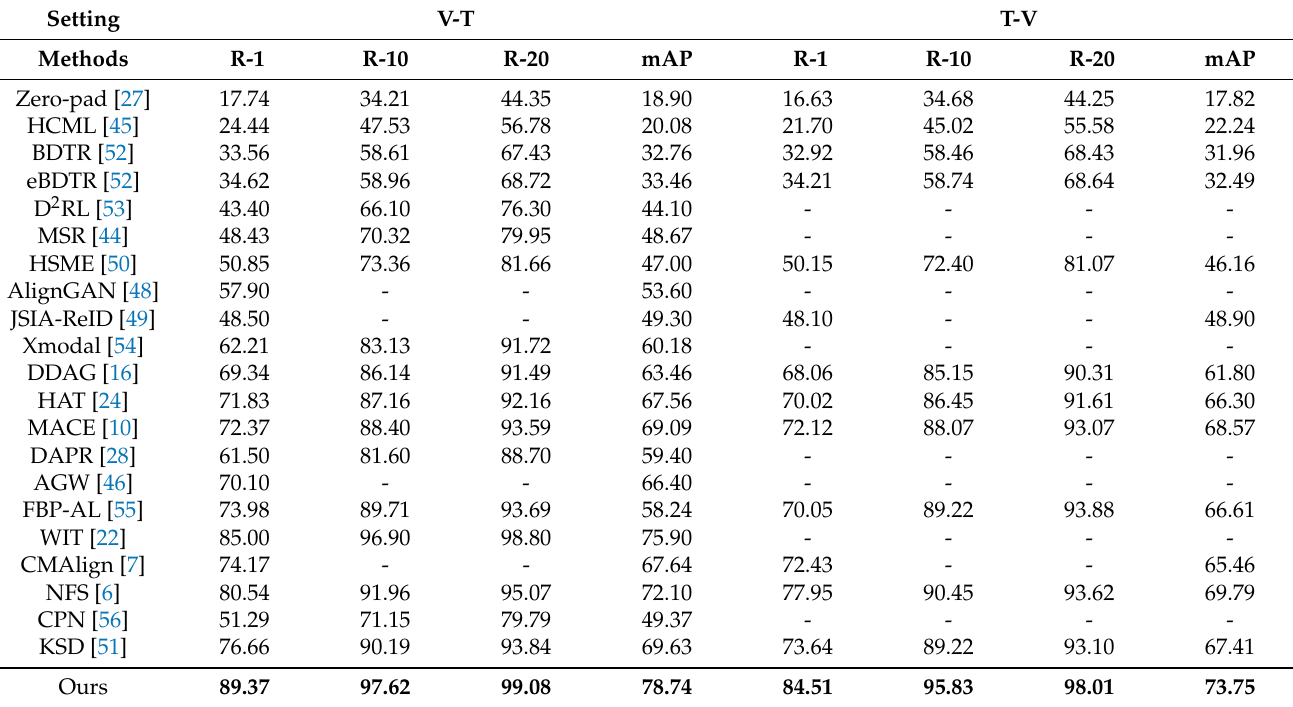
Table 2. Comparisons with the state-of-the-art methods on RegDB for visible-infrared and infrared- visible settings. R-i indicates Rank-i. The bold indicates the best result.